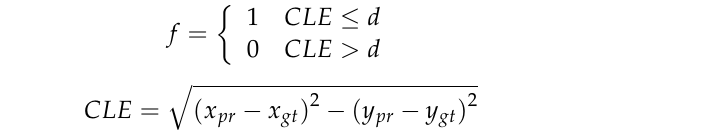
Table 1. The differences of the compared methods in the aspects such as published journals, feature representations, multimodal tracking, high-confidence updating, scale estimation and baseline. Tracker Published at